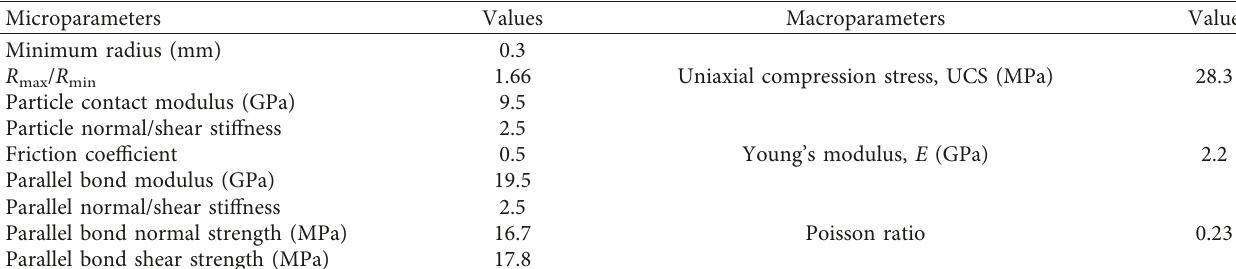
Figure 7: Numerical model and Table 3: Micro- and macrosynthetic parameters.